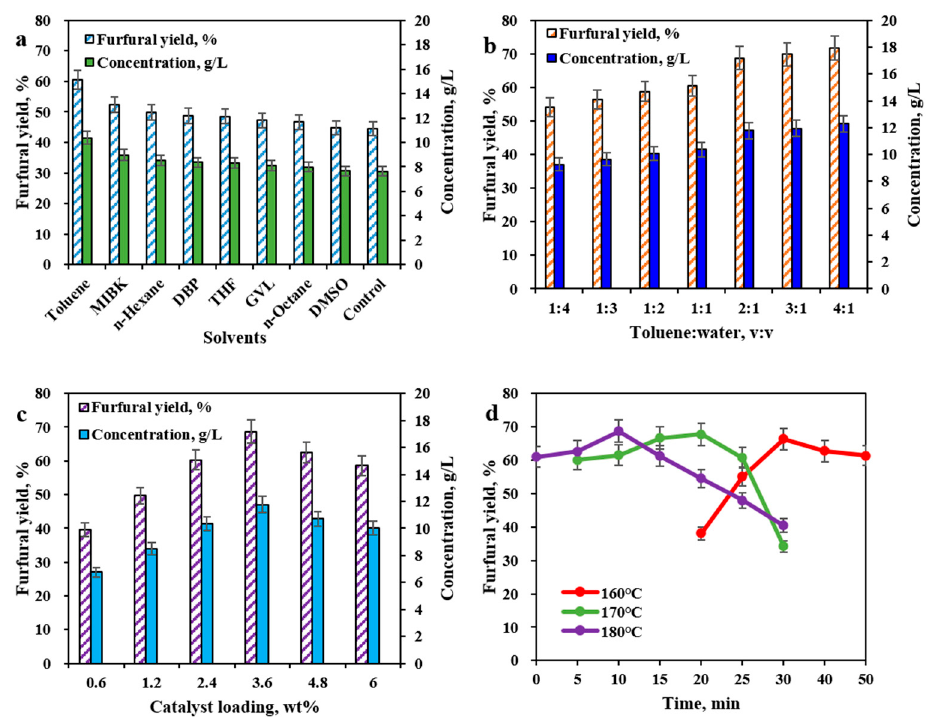
Figure 3. Effects of organic solvent types on the furfural yields in organic solvent–water (1:1, v:v ) (75 g/L CC, 180 °C, 15 min) ( a ); Effects of the toluene-to-water ratio on the furfural yields (1:4–4:1, v : v ) (75 g/L CC, 180 °C, 15 min) ( b ); Effects of catalyst CSUTS-CSW loading (0.6–6 wt%) on the furfural yields in toluene–water (2:1, v : v ) (75 g/L CC, 180 °C, 15 min) ( c ); Effects of temperature (160– 180 °C) and time (5–60 min) on the furfural yields in toluene–water (2:1, v : v ) (75 g/L CC, 3.6 wt% CSUTS-CSW) ( d ). (±Standard error ( n = 6), p ≤ 0.05).